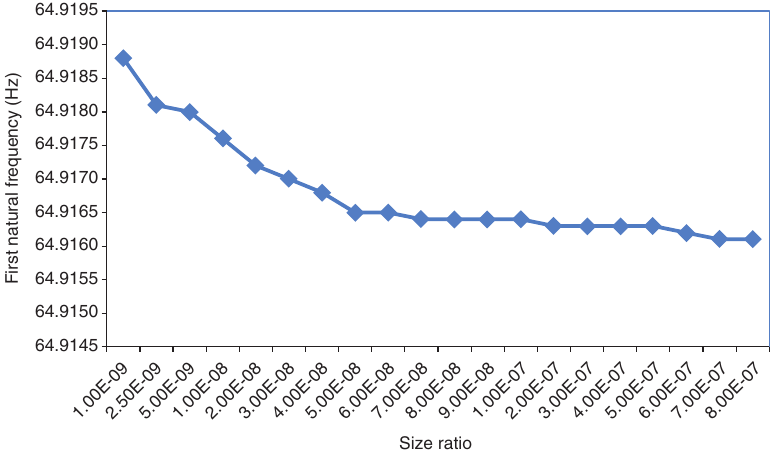
Figure 13: Variations of the first natural frequency of the cantilever beam with size ratio.